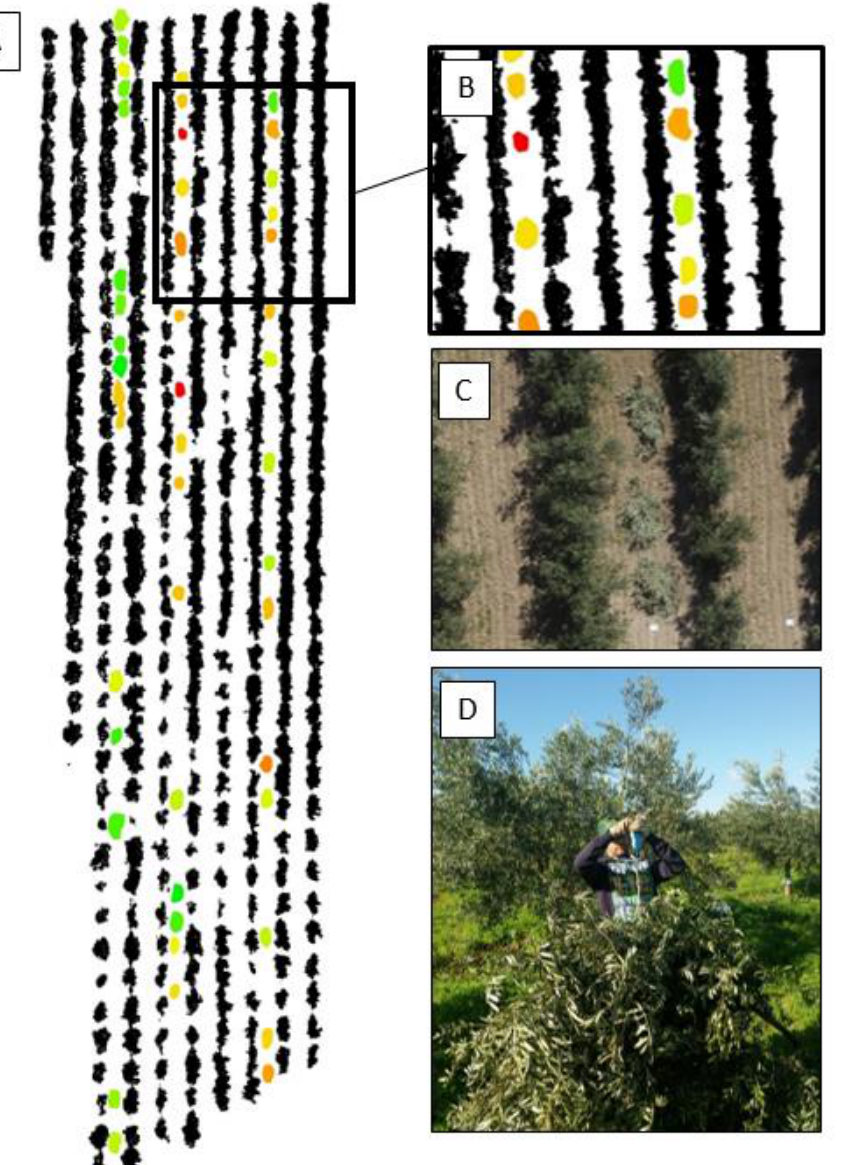
Figure 1. Image segmentation of tree canopies (black) and pruning material (colors) at the experi- mental olive orchard ( A ). Magnification of an olive orchard area ( B ), aerial view (RGB image) of tree canopies and pruning material ( C ), weighting of the pruning material using a weight scale ( D ).